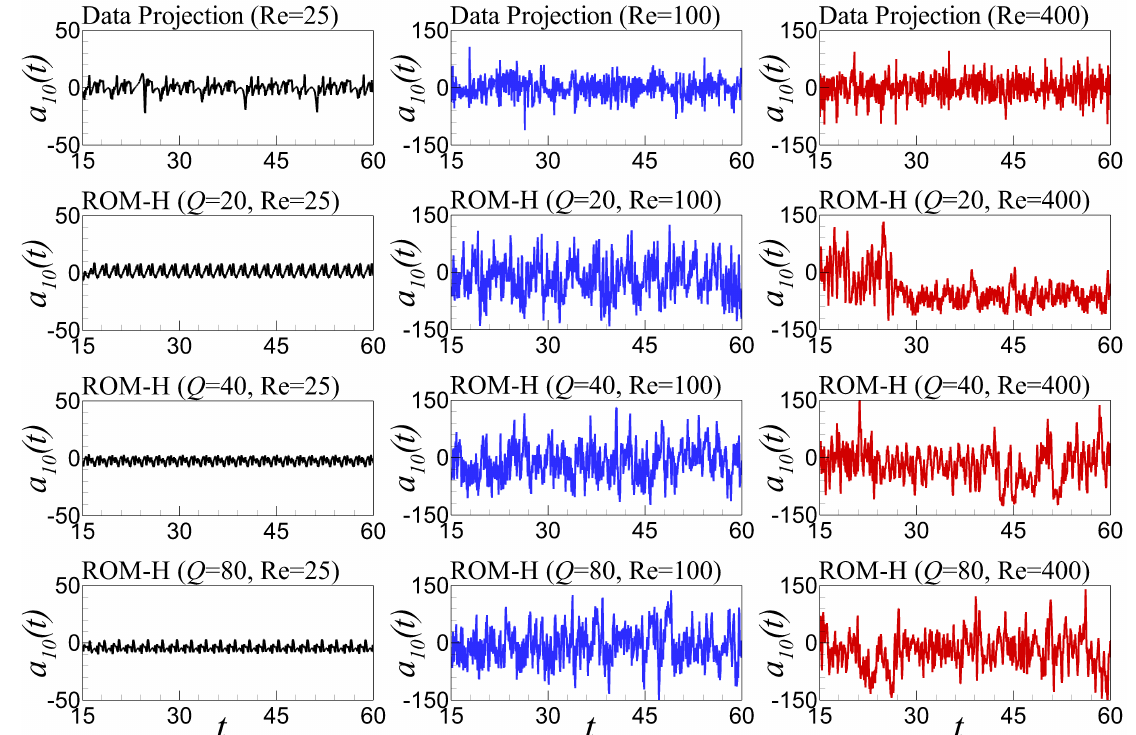
Figure 20. Sensitivity analysis with respect to the number of ELM neurons of ROM-H approach using time series of the tenth modal coefficient, a 10 ( t ) for Re = 25,100,400 and Q =